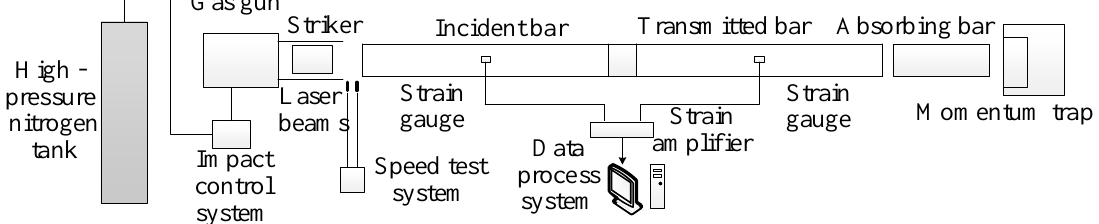
Figure 1. Schematic diagram of the SHPB experimental system.